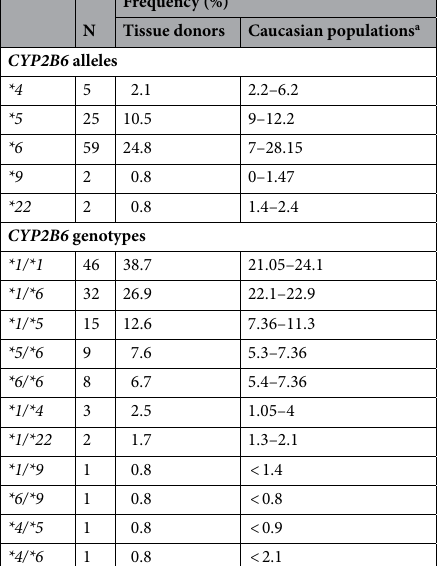
Table 3. Genotype-based prediction of CYP2B6 metabolizer phenotypes according to PharmVar and phenoconversion by non-genetic factors. PM poor metabolizer, IM intermediate metabolizer, EM extensive metabolizer. a According to the CPIC. b CYP2B6 inducers: dexamethasone, methylprednisolone, prednisolone, hydrocortisone, cortisone, midazolam, felodipine, diazepam. c CYP2B6 inhibitor: amlodipine. d Non-specific factors: chronic alcohol consumption, amoxicillin + clavulanic acid